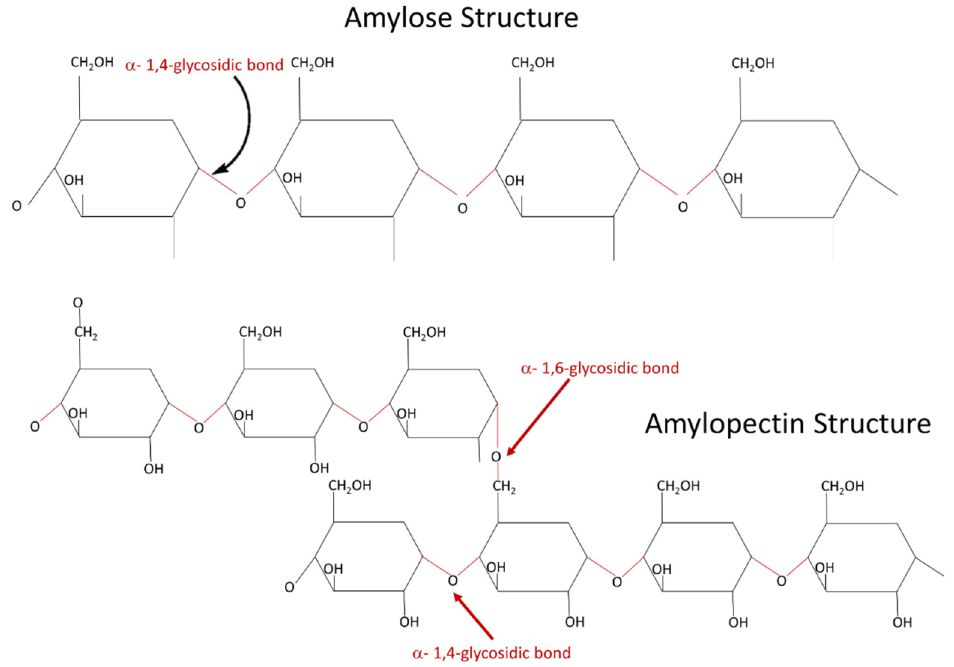
Figure 1. Structures of amylose and amylopectin.